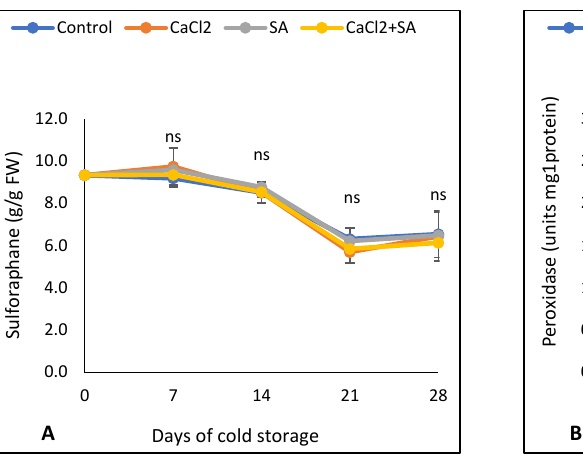
Figure 4. Effect of SA and CaCl 2 and their combination on ( A ) total phenolic, ( B ) vitamin C, ( C ) flavonoids, and ( D ) glucosinolates of broccoli florets stored at 5 °C for 28 days. Values are means ± SE from three replicates ( n = 3). Same letter means no significant differences between the values ( p < 0.05) according to Duncan test.